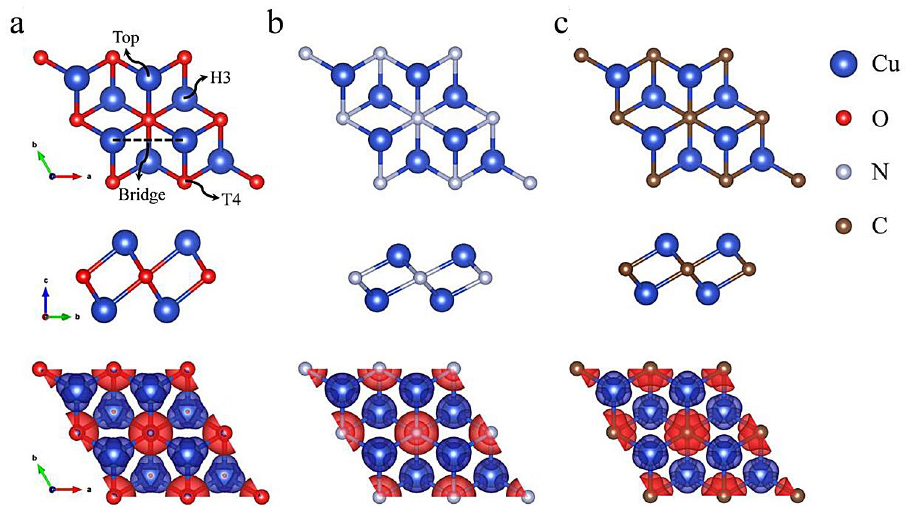
Figure 1. Atomistic representation of the new Cu-based MXene-type structures, the top and side views of ( a ) Cu 2 O, ( b ) Cu 2 N, and ( c ) Cu 2 C. The bottom part represents the electron density difference (Δ ⍴ ). Blue represents depletion, and red is for the accumulation of